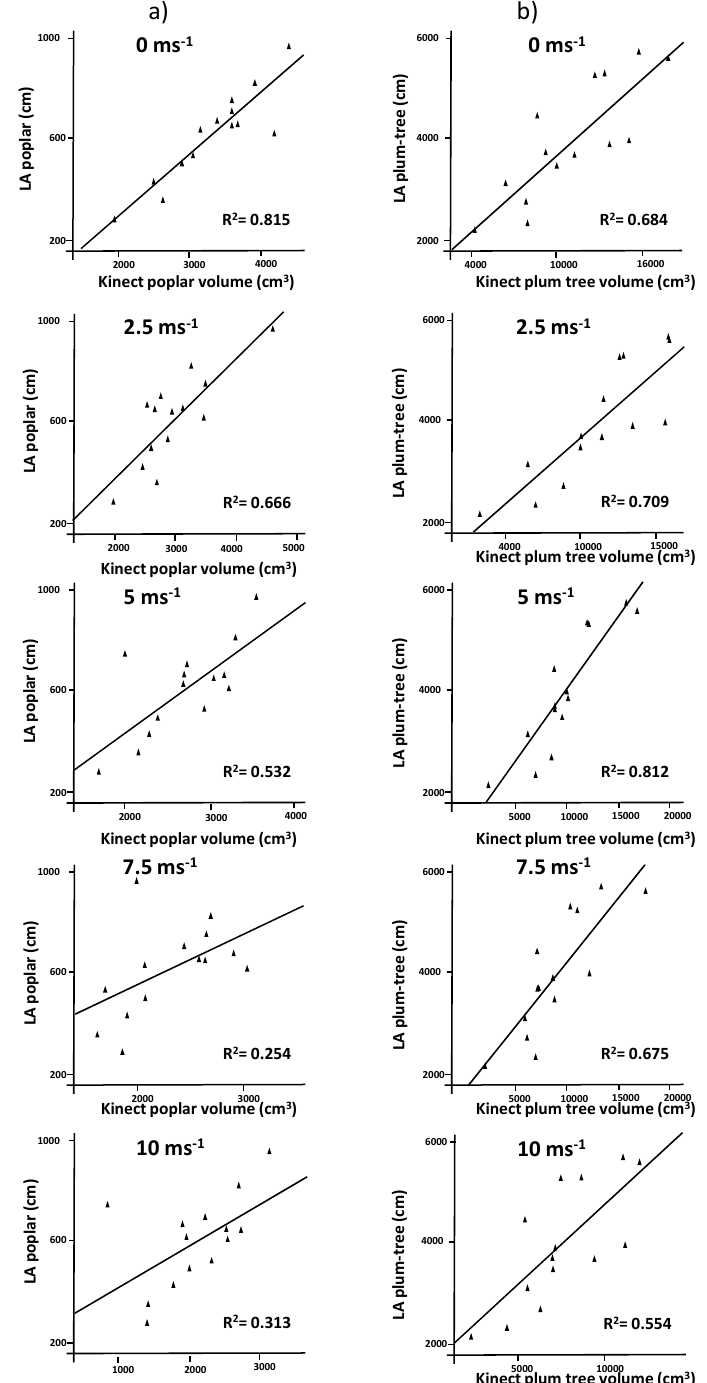
Figure 5. Regression analysis comparing Leaf Area (LA) vs. tree volume for ( a ) poplar trees and ( b ) plum trees at wind speeds ranging from 0 to 10 m·s − 1 .